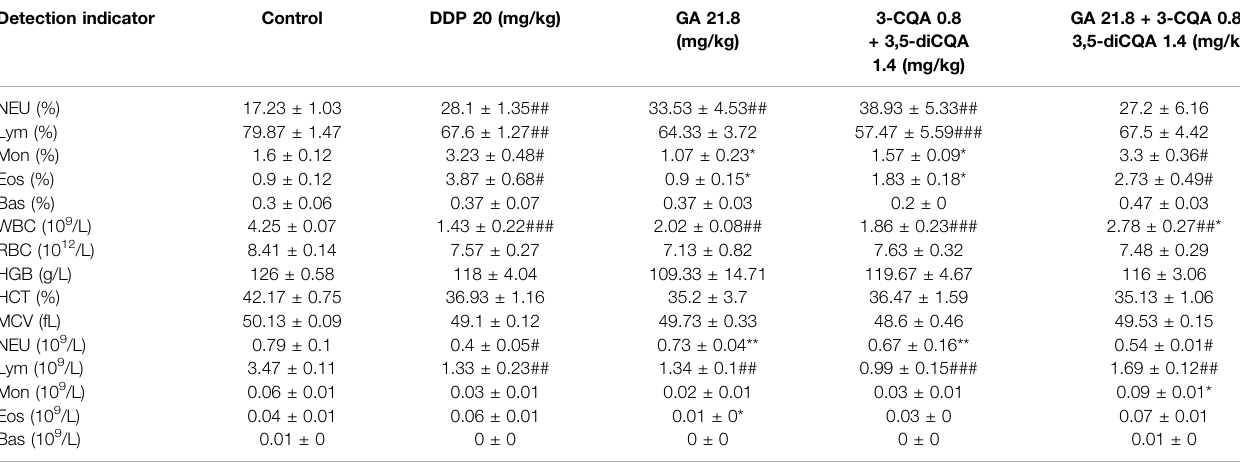
TABLE 8 | Blood cell analysis. Detection indicator